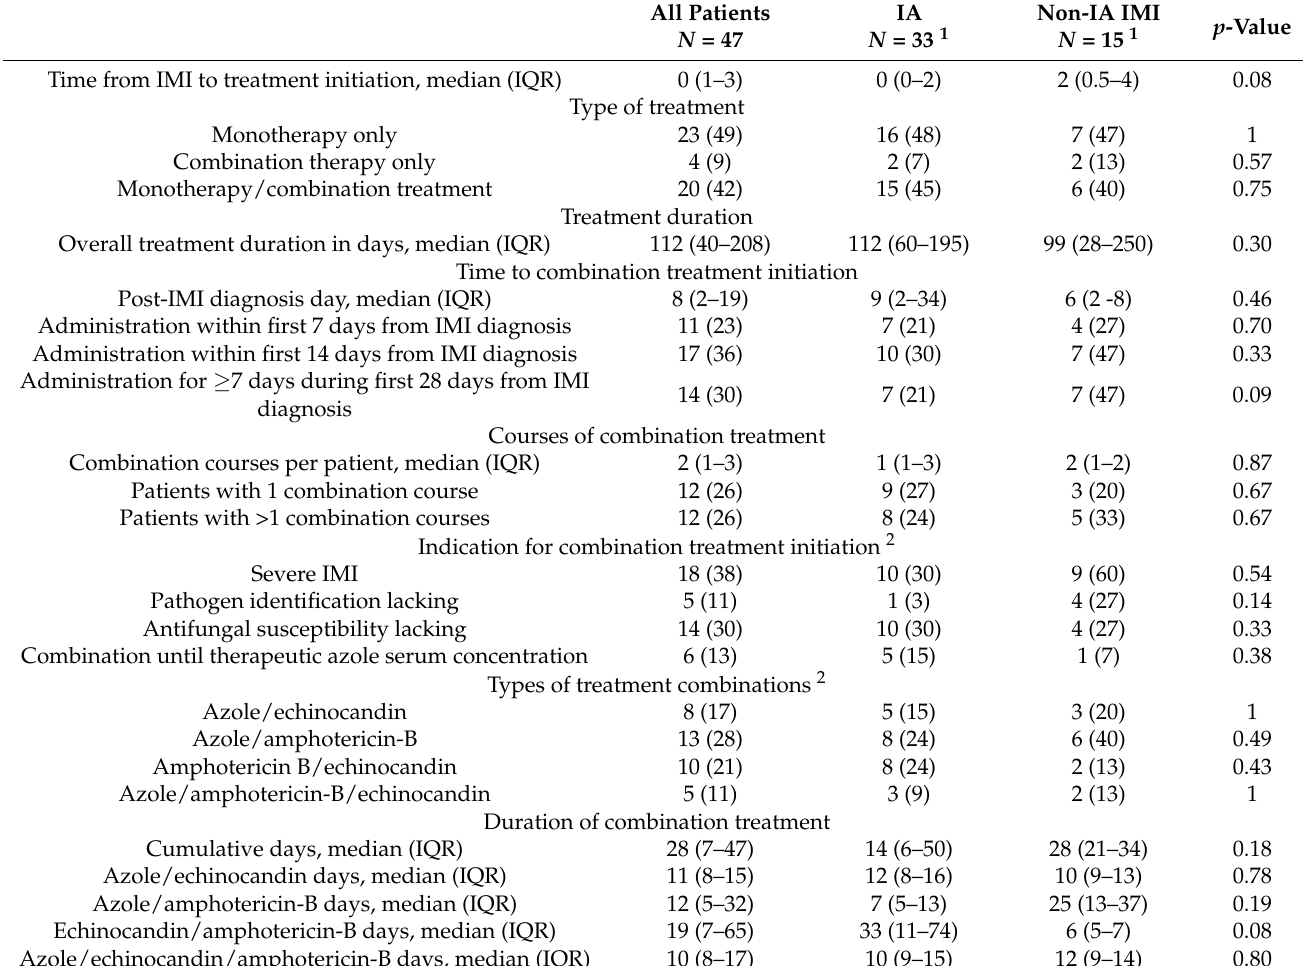
Table 3. Management of IMI with emphasis on combination